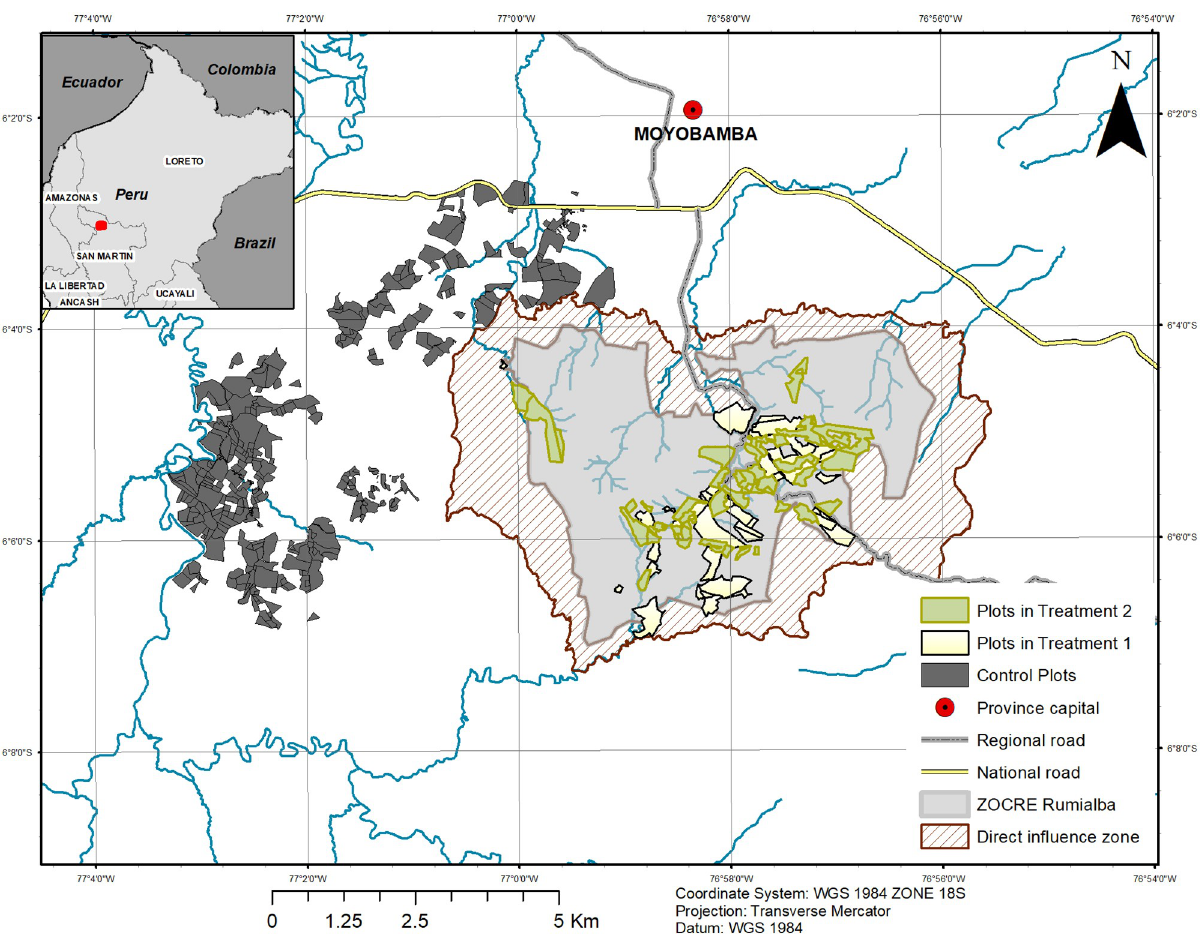
Fig 3. Sampling of treated and control plots: ZOCRE Rumialba (T1) and PES area (T2). Source: own elaboration, based on publicly available data from EPS Moyobamba, PEAM, GORESAM and the Ministry of Transports and